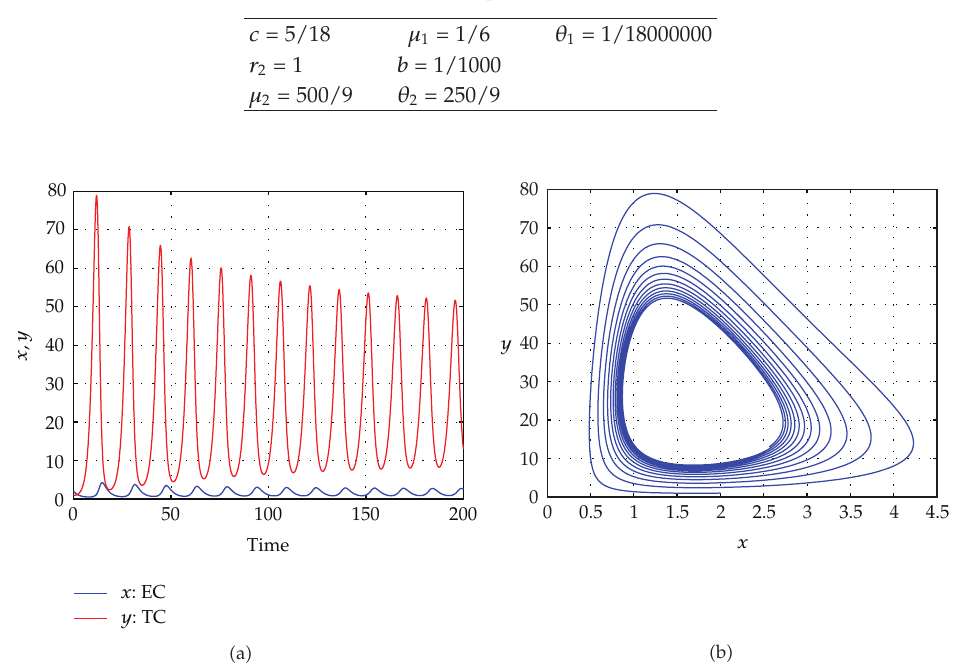
Figure 1: Solution of the DDEs (cid:4) 2.7 (cid:5) when ω (cid:8) 0 . 01184, μ (cid:8) 0 . 3747, s (cid:8) 0 . 1181, r (cid:8) 1 . 636, b (cid:8) 0 . 002, and τ (cid:8) 0 . 8. This shows an unstable endemic